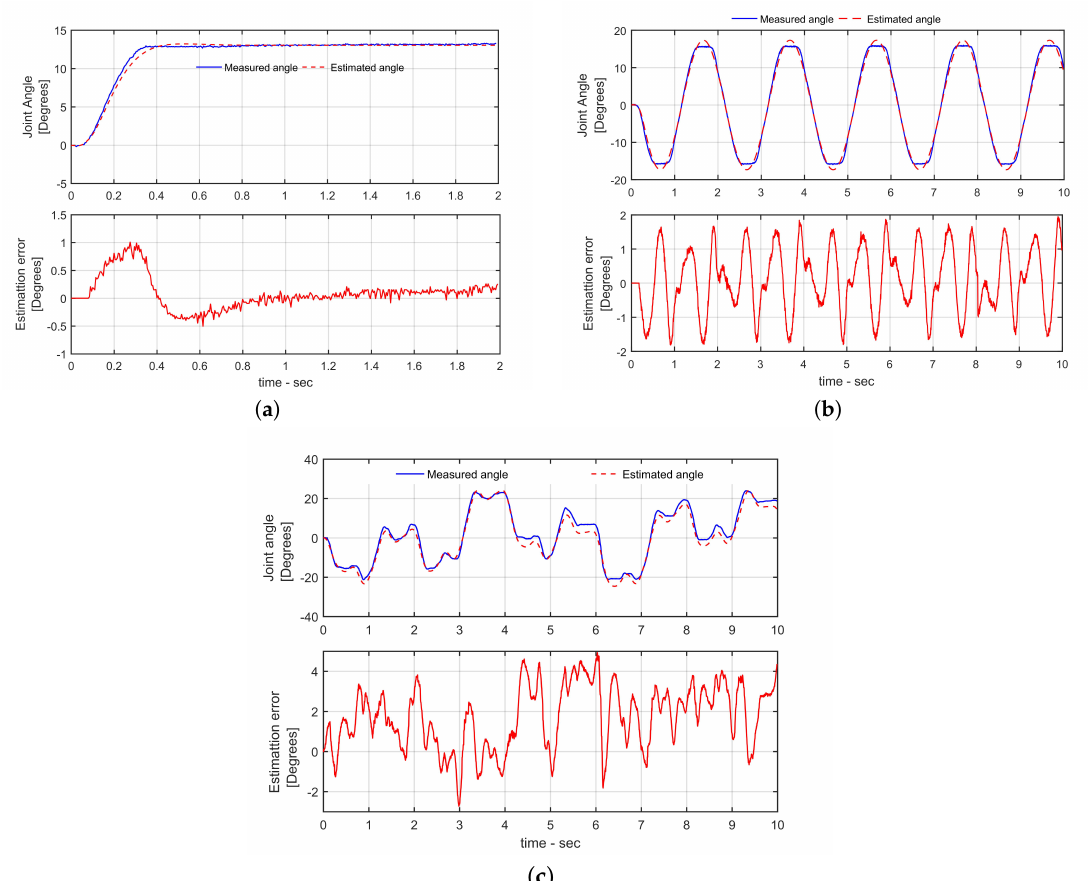
Figure 2. Identification results of the antagonistic actuator: ( a ) the step input of 0.4 MPa, ( b ) the 0.5 Hz sinusoidal signal, and ( c ) the time-varying amplitude and frequency control input. Upper sub-figures show measured (blue line) and estimated (dash red line) show value of the actuator angle. Lower sub-figures show the estimation error of the mathematical